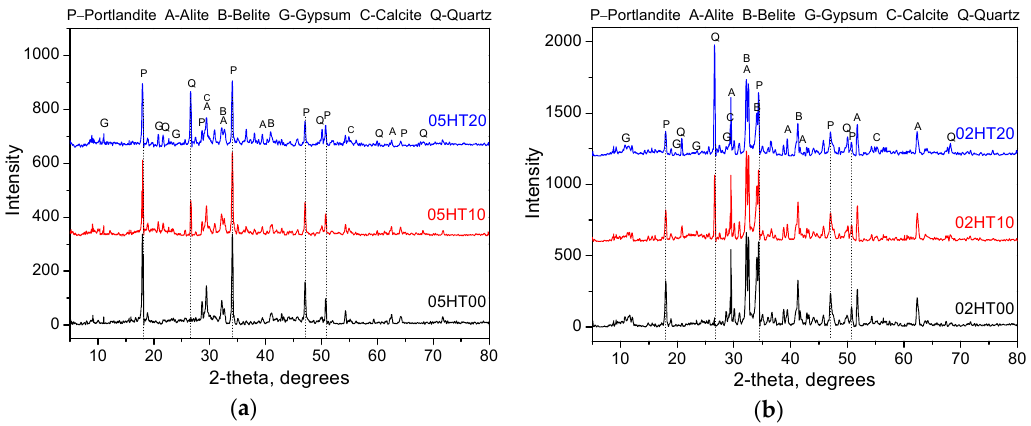
Figure 12. X-ray diffraction curves obtained for all the samples at 28 days when ( a ) w/b = 0.5 and ( b ) w/b = 0.2.